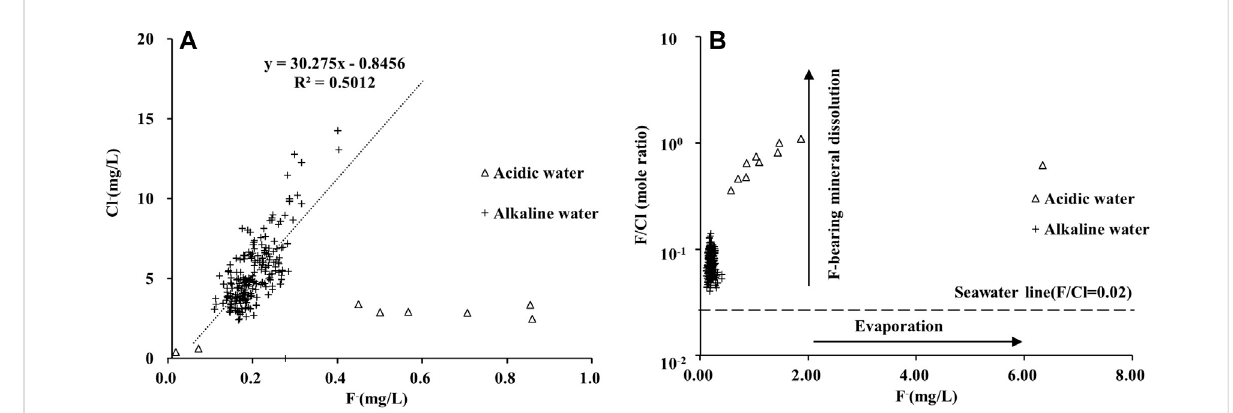
FIGURE 6 (A) Relationship between Cl − and F − ; (B) F − /Cl − versus F − in the Huatan River.